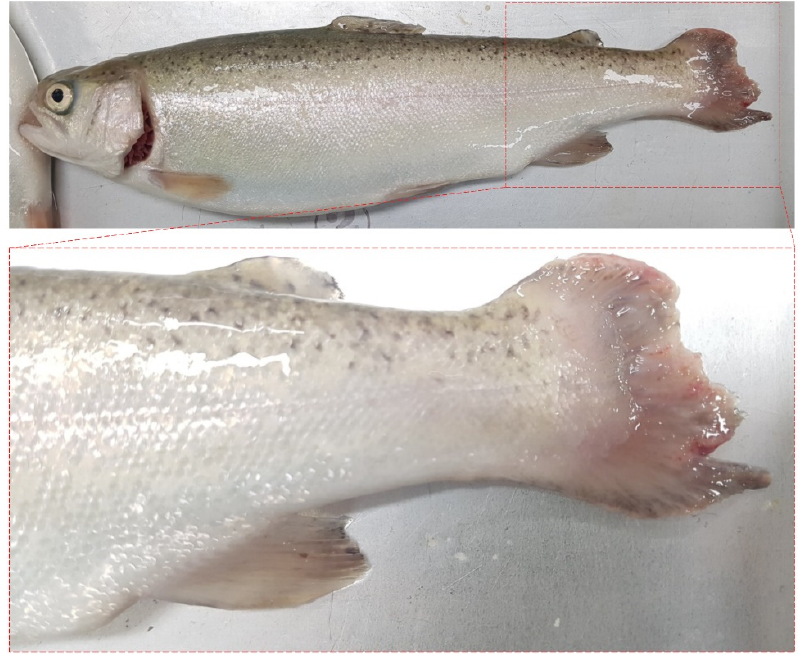
Figure 1. Clinical symptoms of Chryseobacterium balustinum infection indicate severe damage on the dorsal and caudal fin.